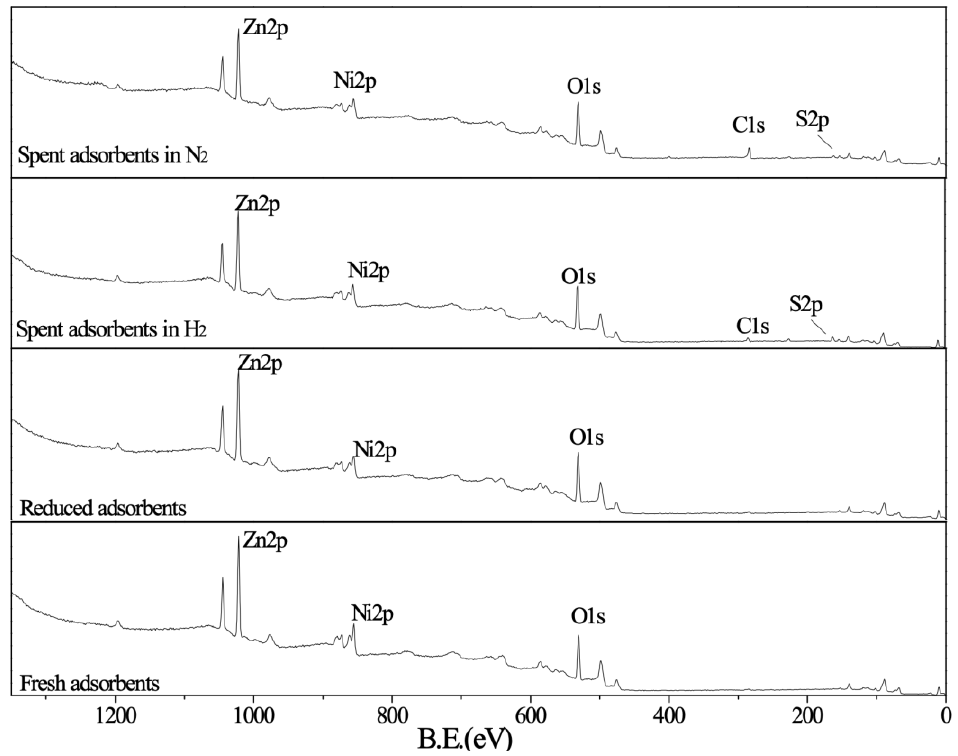
Figure 5. X-Ray Photoelectron Spectroscopy (XPS) spectra of fresh, reduced and sulfurized